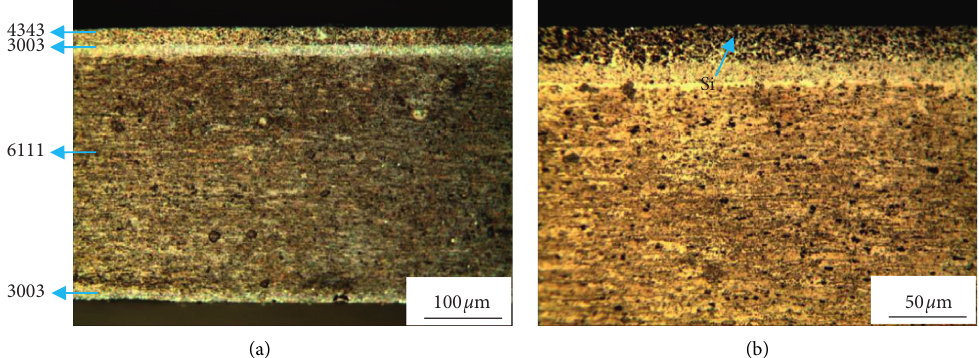
Figure 7: Microstructures of the 4343/3003/6111/3003 clad sheets that were rolled to 30% and annealed at 410 ° C: (a) 100x and (b) 200x.